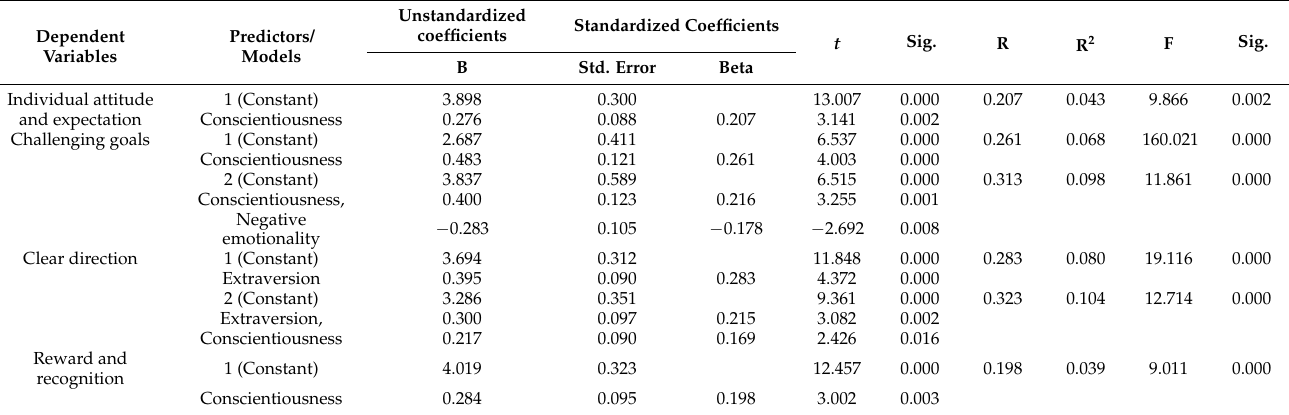
Table 8. Multiple linear regression models in the group of non-participants of computer programming courses, the dependent variables are learning motivating factors, and the predictors are personality traits. Dependent